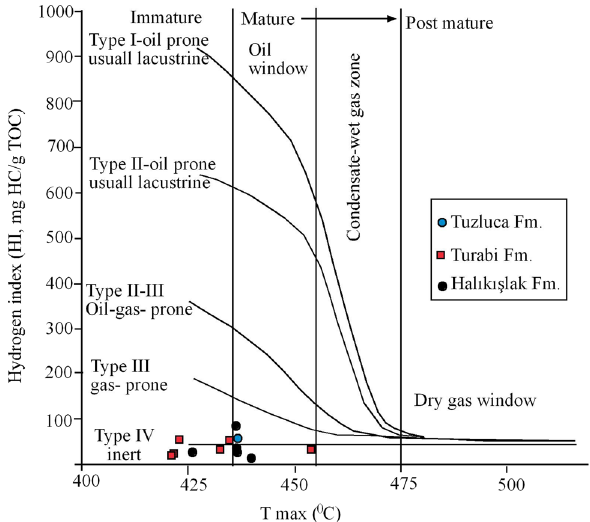
Fig. 6 Plot of hydrogen index (HI) versus pyrolysis T lyzed peat and shale sediments, showing kerogen quality and thermal maturity stages (modified after Mukhopadhyay et al.